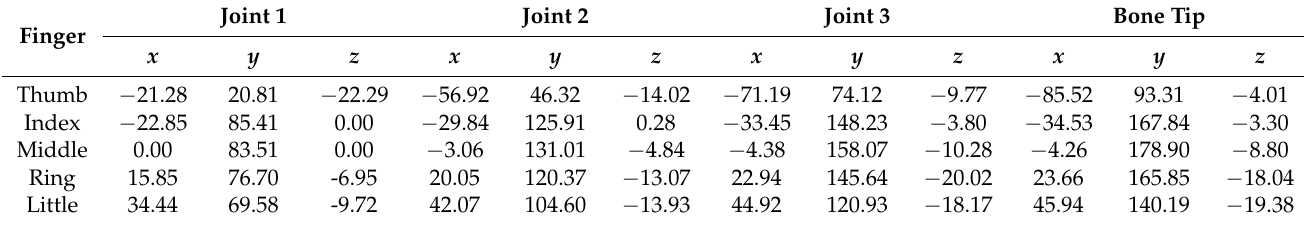
Table 1. Locations of hand joint centers and bone tips for a participant.